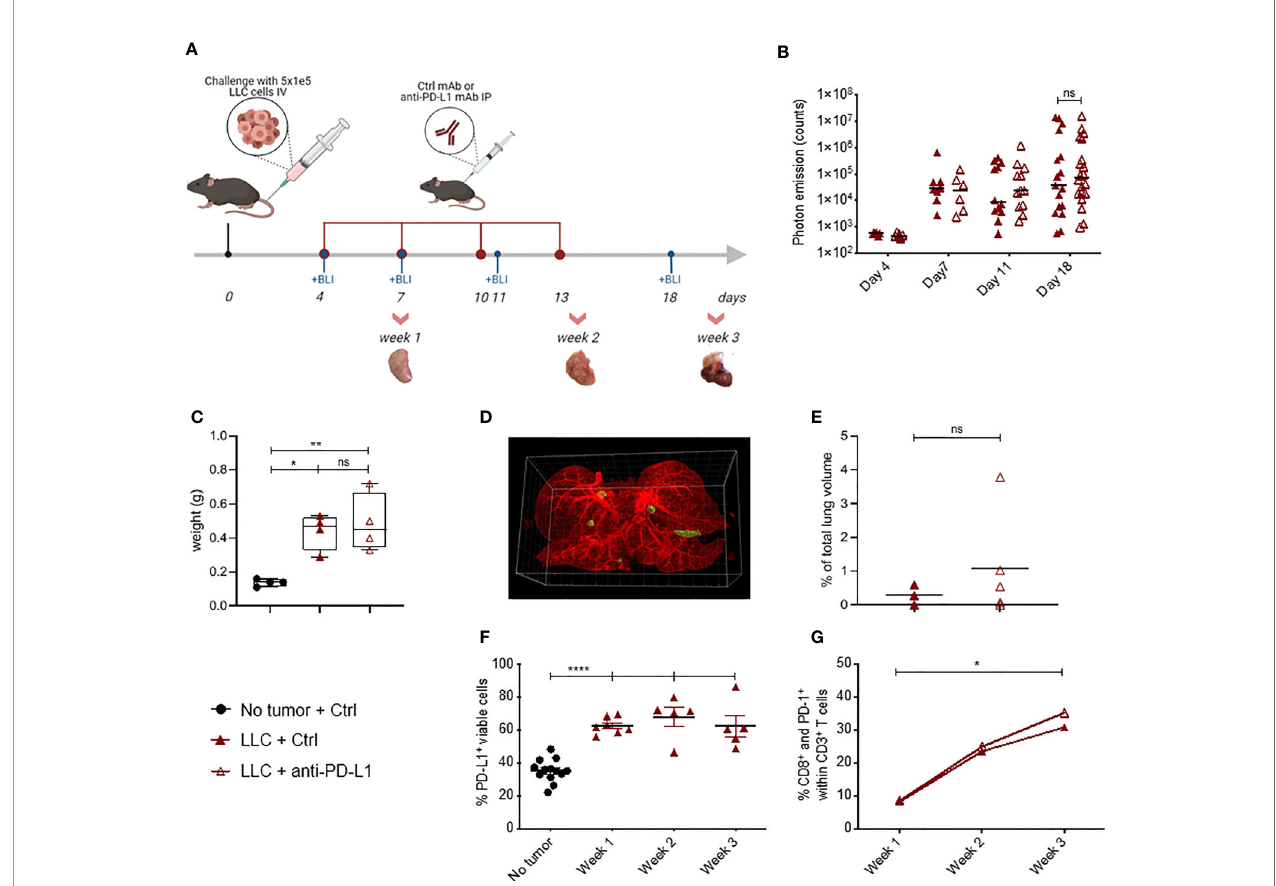
GE FIGURE 1 | Blockade of PD-L1 does not delay LLC-Fluc tumor progression, despite PD-(L)1 expression. (A) Schematic representation of the experimental set-up. Mice were challenged intravenously (IV) with LLC-Fluc cells and treated every 3 days with anti-PD-L1 or isotype control (Ctrl) mAbs for 4 times in total (red dots). LLC-Fluc engraftment was monitored using in vivo bioluminescence imaging (BLI) on the indicated time points (blue dots), while on weeks 1, 2 and 3, lungs were also isolated for fl ow cytometric evaluation. (B) Summary of photon counts collected upon BLI measurements. On a logarithmic scale, the absolute number of counts per analyzed day (on x-axis) are shown (n=3, 5 mice per condition [mpc]). A two-way ANOVA with Sidak ’ s multiple comparisons test was performed to evaluate statistical signi fi cance. (C) Weights of whole lungs, isolated from healthy or tumor-bearing mice sacri fi ced three weeks after cancer initiation (n=1, 4-5 mpc). (D) A representative 3D image that is used for volumetric quanti fi cation of tumor volumes (green) in an Ctrl mAb-treated murine lung (auto fl uorescence, red), obtained with Imaris software. (E) Percentage of tumor volume over whole lung volume to compare LLC engraftment in mice treated with Ctrl mAbs or anti-PD-L1 mAbs (n=3-4). Statistical signi fi cance was measured using an unpaired t-test. (F) Graph representing the percentages of PD-L1 + cells found upon fl ow cytometry analysis of the viable lung single-cell fraction, isolated from healthy or LLC-Fluc tumor-bearing mice on weeks 1-3 after tumor challenge (n=3, 1-3 mpc). (G) Percentage of lung tumor-in fi ltrated PD-1 + CD8 + T-cells within the CD3 + T-cell population at 1, 2 and 3 weeks after LLC-Fluc inoculation analyzed via fl ow cytometry (n=3, 1-3 mpc). A two-way ANOVA with Tukey ’ s multiple comparisons test was performed to determine statistical signi fi cance in panels (C, F, G) . ns, non-signi fi cant; * for p < 0.05; ** for p < 0.01; and **** for p <